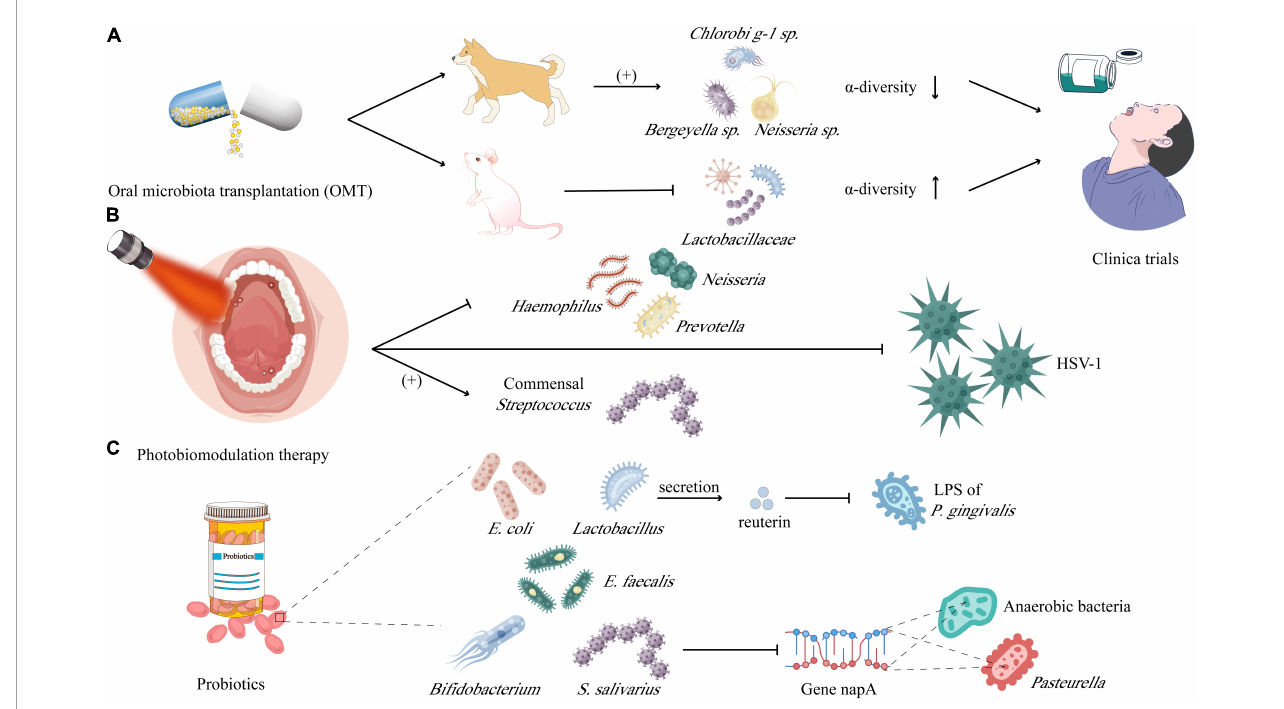
FIGURE4 Microbiota in prevention and therapy of mucositis and ulcerations: (A) oral microbiota transplantation (OMT) was carried out in dogs and found that the relative abundance of Chlorobi g-1 sp. , Neisseria sp., and Bergeyella sp. increased rather than α -diversity; while downregulating the Lactobacillaceae but increasing the α -diversity in mice. (B) Photobiomodulation therapy is demonstrated to inhibit the Haemophilus , Neisseria , and Prevotella , instead benefiting the commensal Streptococcus , meanwhile which is lethal to HSV-1, too. (C) Probiotics including Lactobacillus, Bifidobacterium, Escherichia coli, and Escherichia faecalis , could neutralize the lipopolysaccharide (LPS) of Porphyromonas gingivalis by secreting the reuterin and inhibiting Pasteurella and anaerobic bacteria by downregulating the expression of gene encoding nitrate reduction (napA).